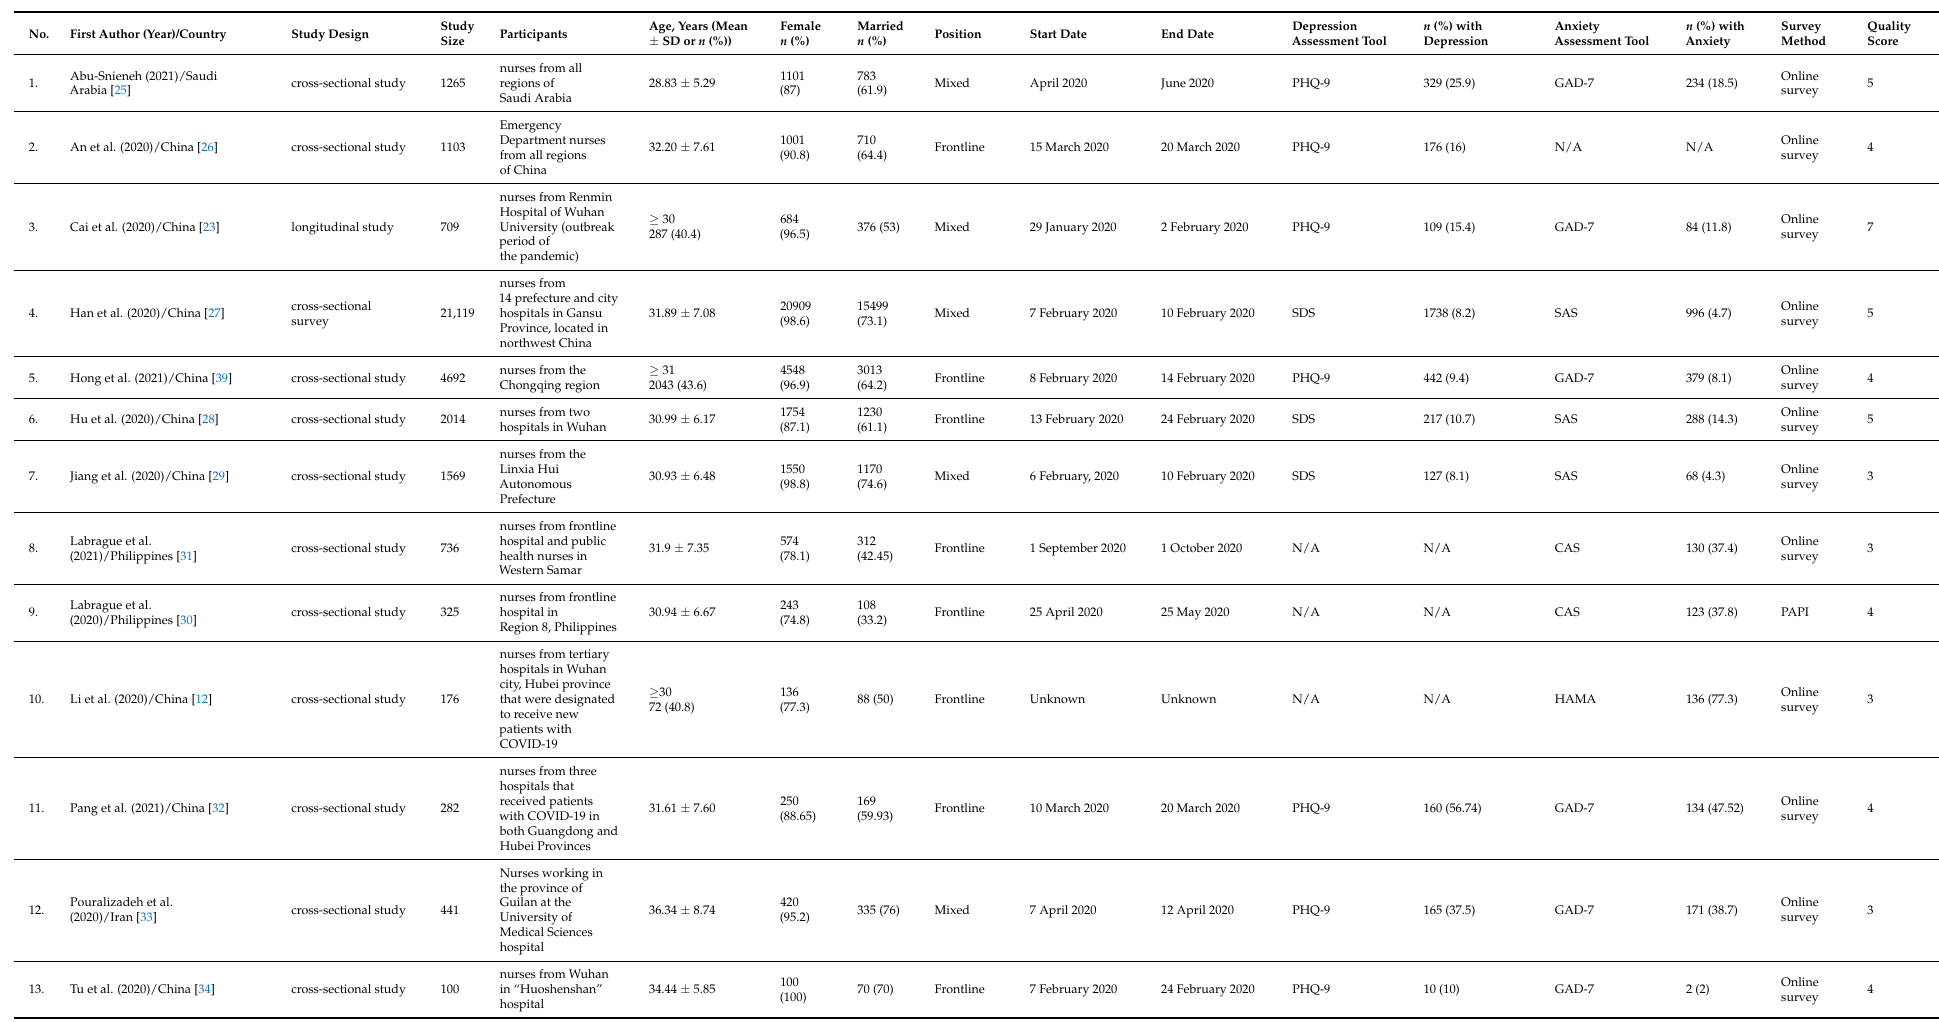
Table 1. Characteristics of the included